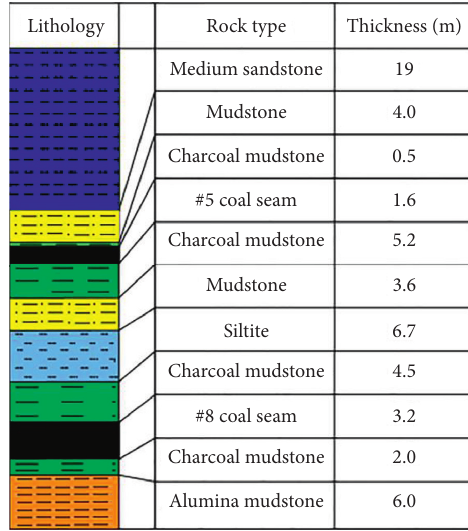
Figure 2: Bar chart of coal seam geology of the coal